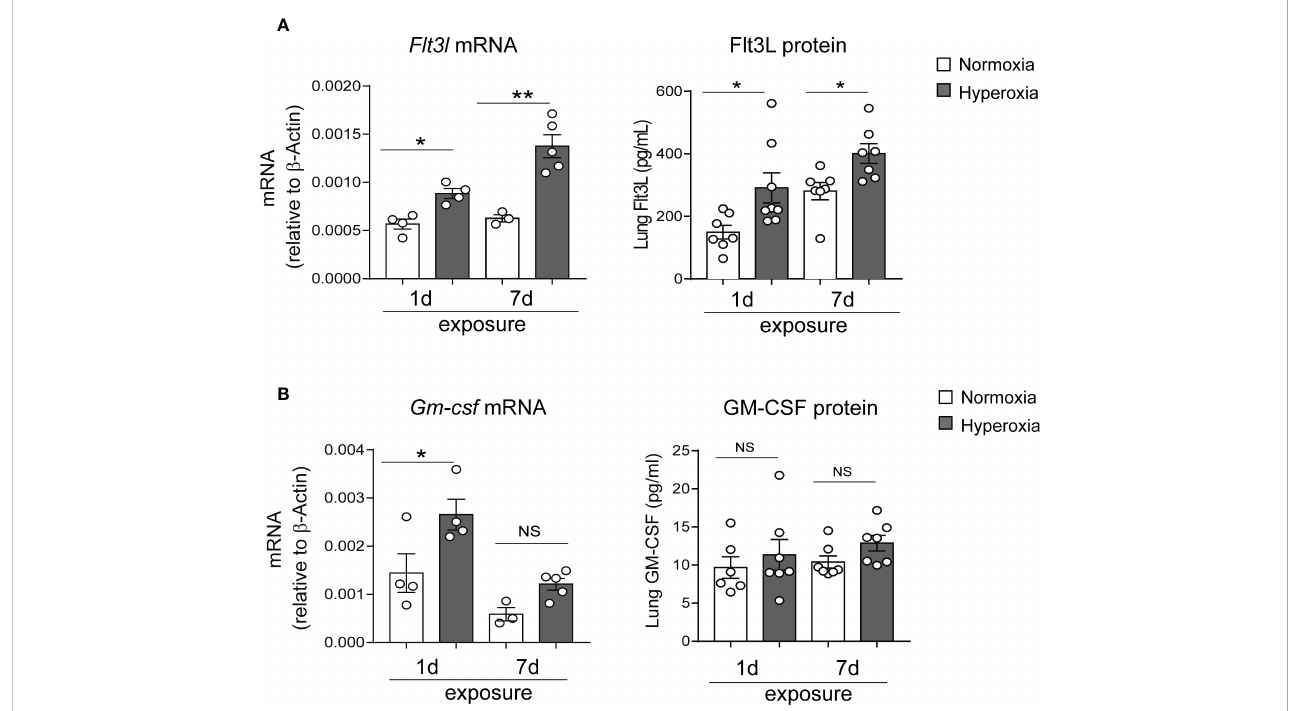
FIGURE 4 Hyperoxic exposure increased Flt3L but not GM-CSF levels in neonatal mouse lung. Whole lung tissue was homogenized in PBS after 1d and 7d of normoxia (white bar) or hyperoxia (black bar) exposure. Proteins were measured by ELISA in the supernatant. RNA was extracted from part of the homogenate and was used for qPCR. Flt3L (A) and GM-CSF (B) protein levels and mRNA expression were quanti fi ed. These results are representative of two independent experiments. * P <0.05 or ** P <0.01 (one-way ANOVA), NS, non-signi fi